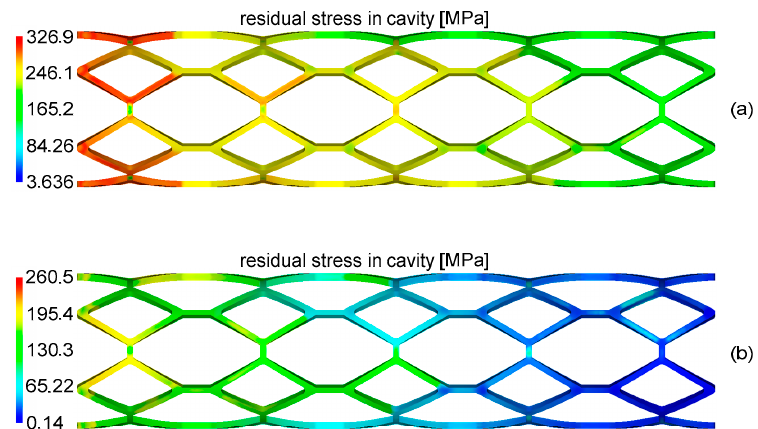
Figure 8. The distribution of residual stress of the comparable design and optimal design. ( a ) The distribution of residual stress of the comparable design; ( b ) The distribution of residual stress of the optimal design.